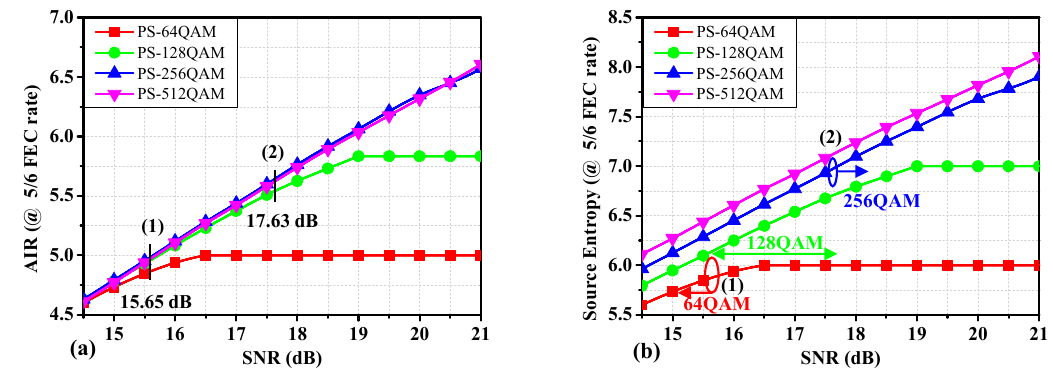
Figure 4. The AIR, SE and GMI performance at 0.86 NGMI threshold. ( a ) AIR performance at 0.86 NGMI threshold. ( b ) SE performance at 0.86 NGMI threshold.